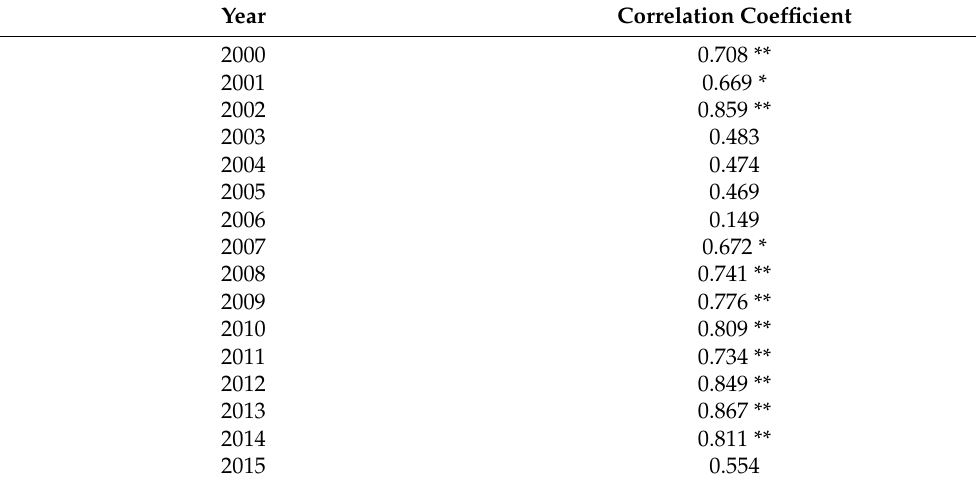
Table 2. Correlation analysis between SM and precipitation.